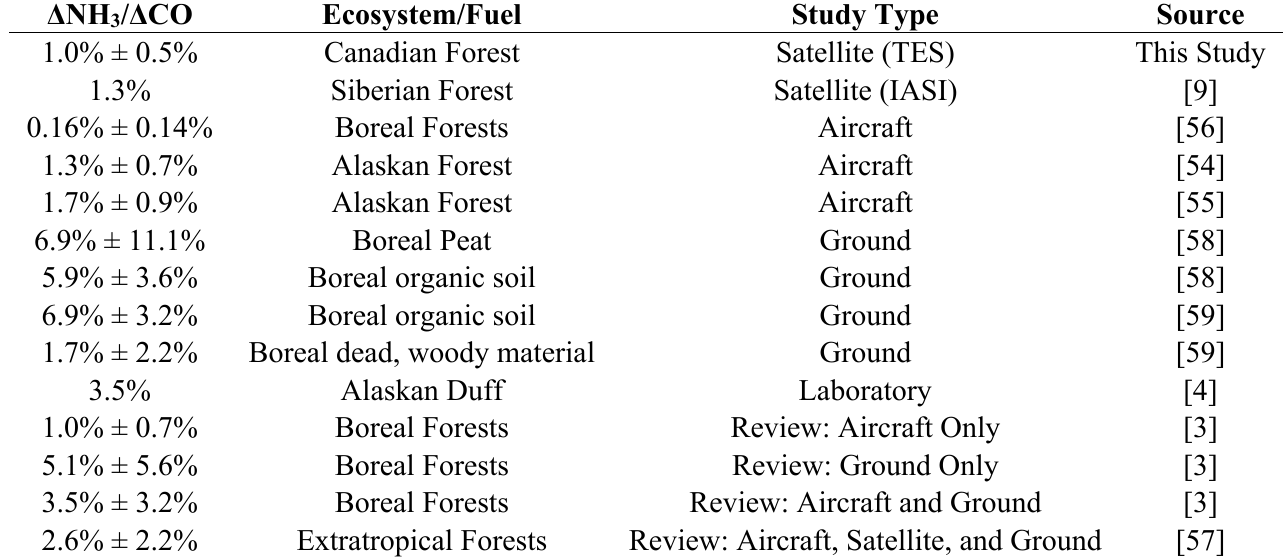
/ Δ CO, mol/mol) for boreal biomass 3